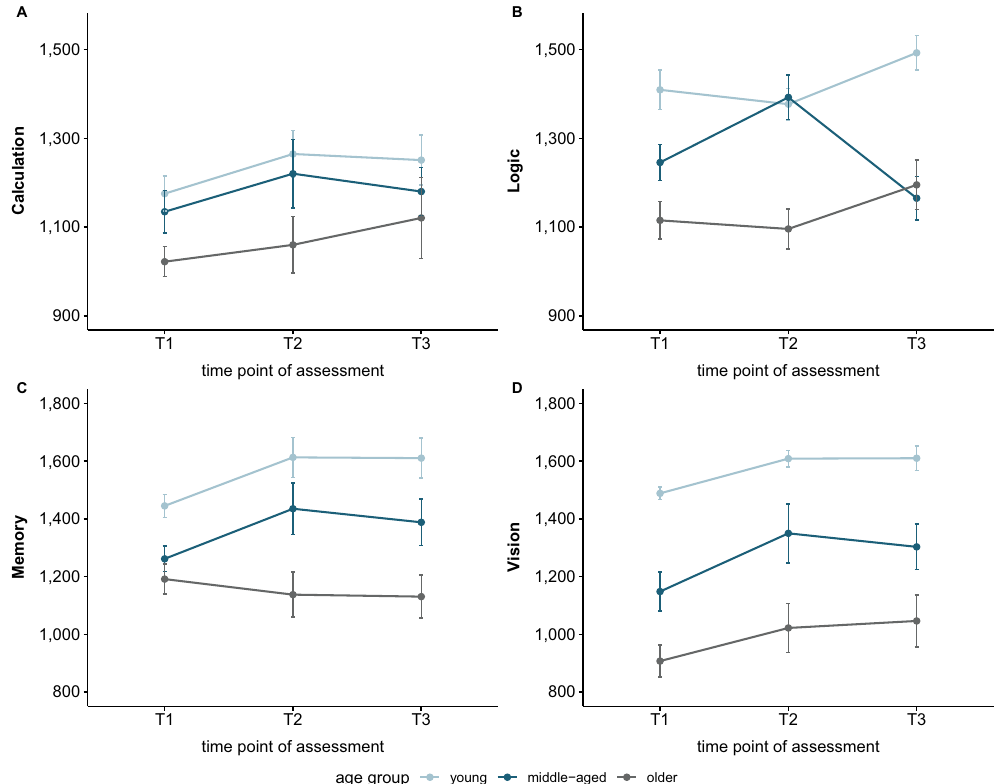
Figure 4. Performance in points within the objective cognitive areas over time. (a) Calculation. Assessed with two tasks, in which participants had to solve empty equations or return the right change. (b) Logic. Assessed with two tasks, in which participants had to solve a problem deductively and solve a progressive matrices-like task. (c) Memory. Assessed with two tasks in which participants conducted a working memory recall and an updating task. (d) Vision. Assessed with three tasks, in which participants underwent a feature conjunction visual search, mental rotation and a Stroop-like